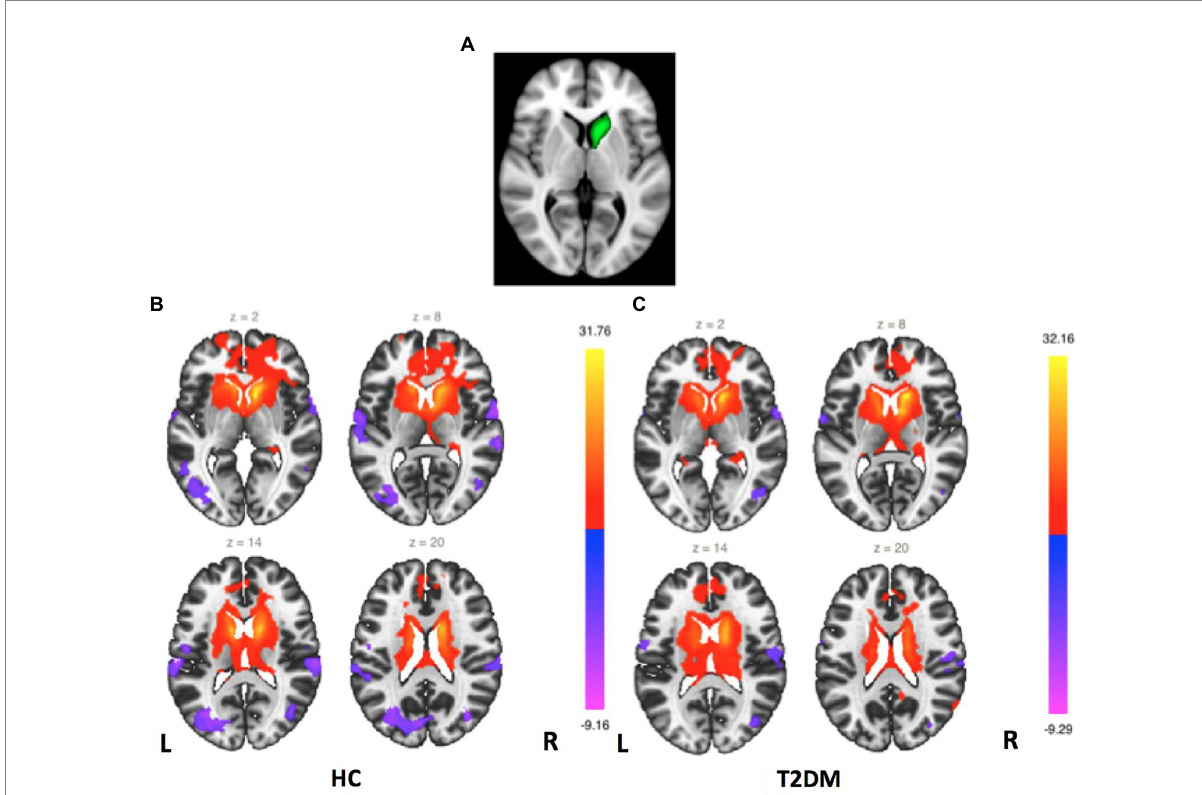
FIGURE 1 Right caudate FC maps. (A) Right caudate seed region. (B) FC maps for the HC group (second-level analysis, p < 0.05, FDR corrected). (C) FC maps for the T2DM group (second-level analysis, p < 0.05, FDR corrected).